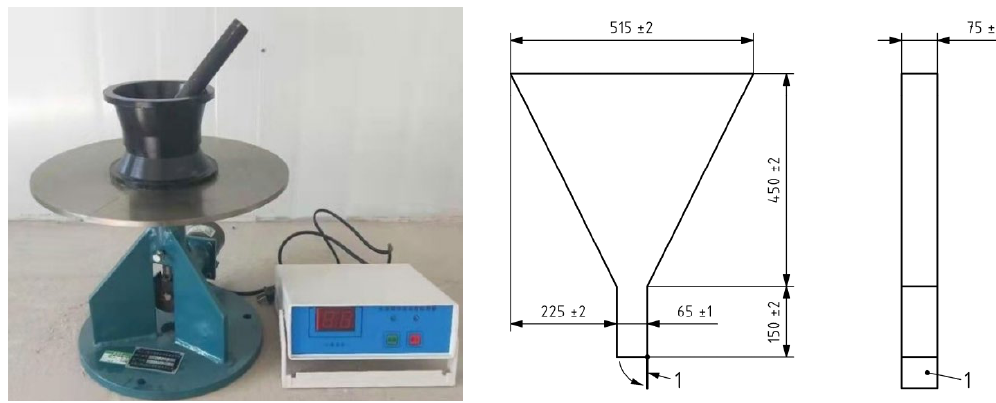
Figure 9. Left: NLD-3 cement sand flow tester; Right: V-funnel.